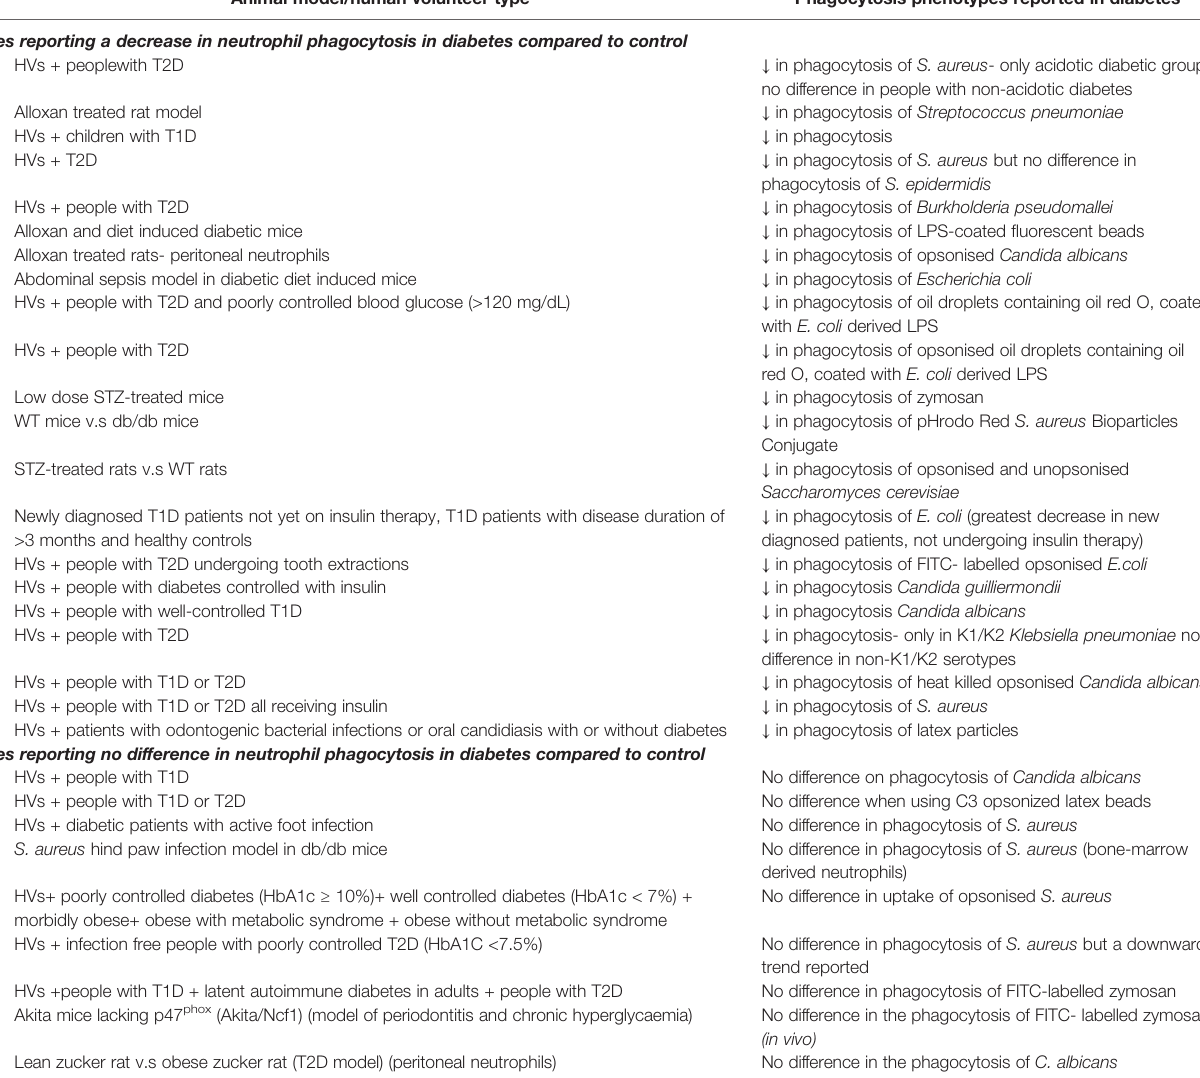
TABLE 3 | Studies investigating neutrophil phagocytosis in diabetes. Study Animal model/human volunteer type Phagocytosis phenotypes reported in diabetes